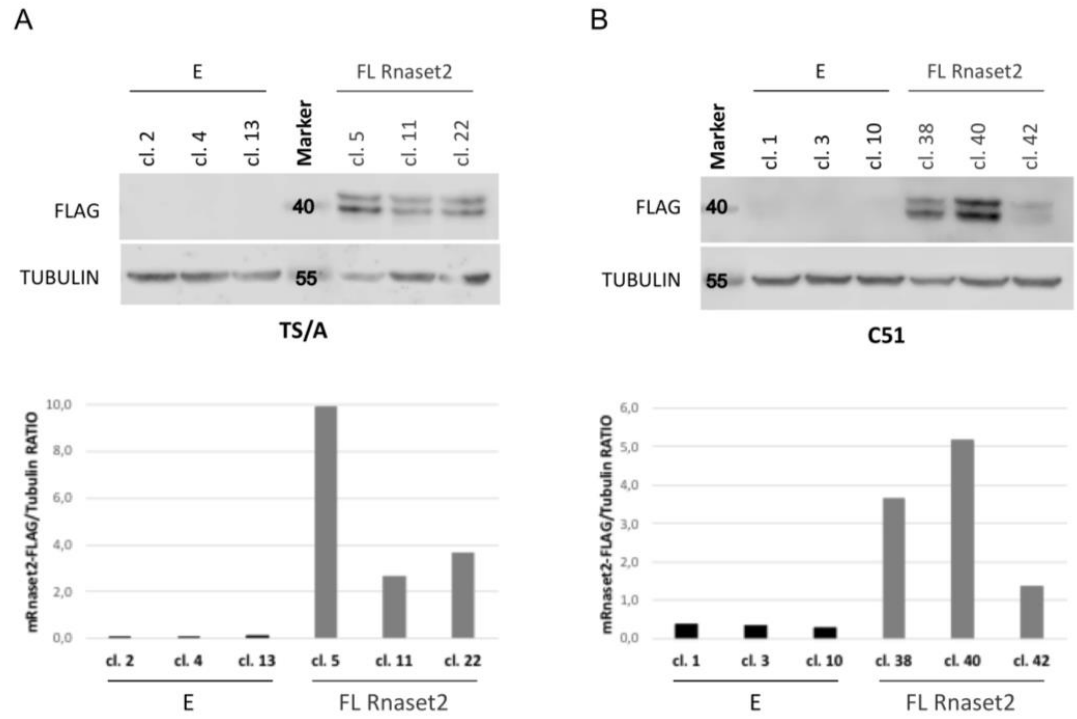
Figure 1. Immunoblot analysis of murine Rnaset2 -overexpressing clones in TS / A (panel A ) and C51 (panel B ) tumor cell lines. The images showing the whole-filter picture from the western blots shown above are provided in Figure S2.